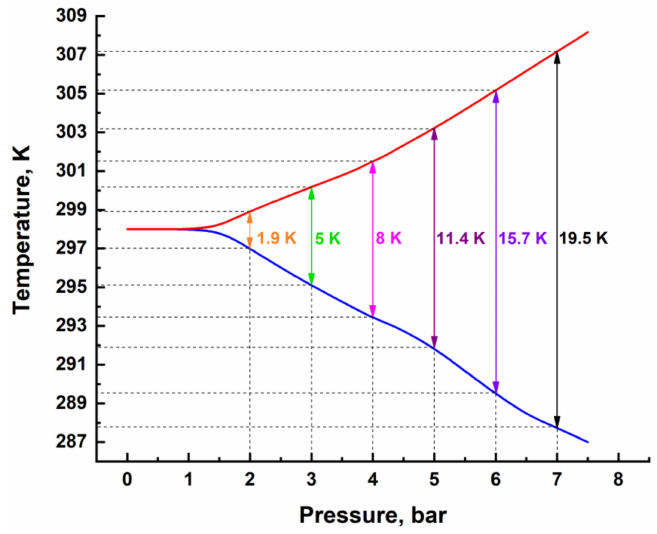
Figure 6. Dependence of copper plate temperatures on the pressure at the inlet of the vortex